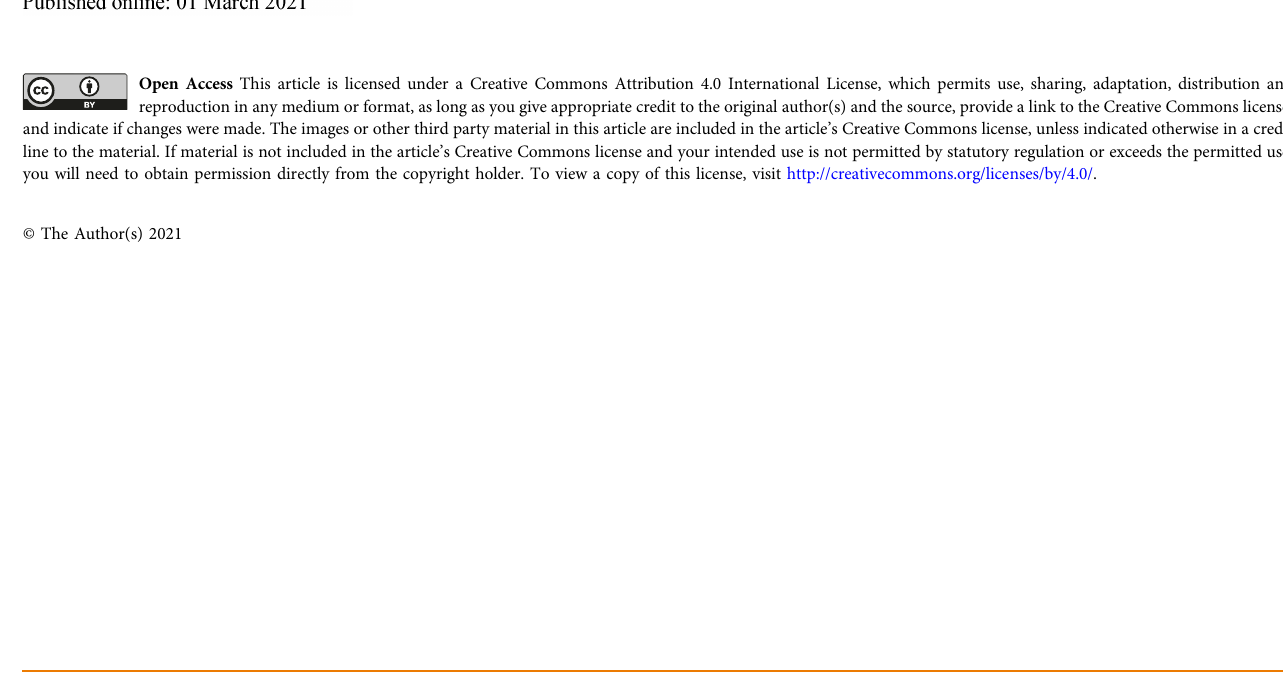
Correction 1: Figure panels 3g and 3h in the original version of this article were inadvertently reversed. Correct Fig. 3 with the updated panels is listed